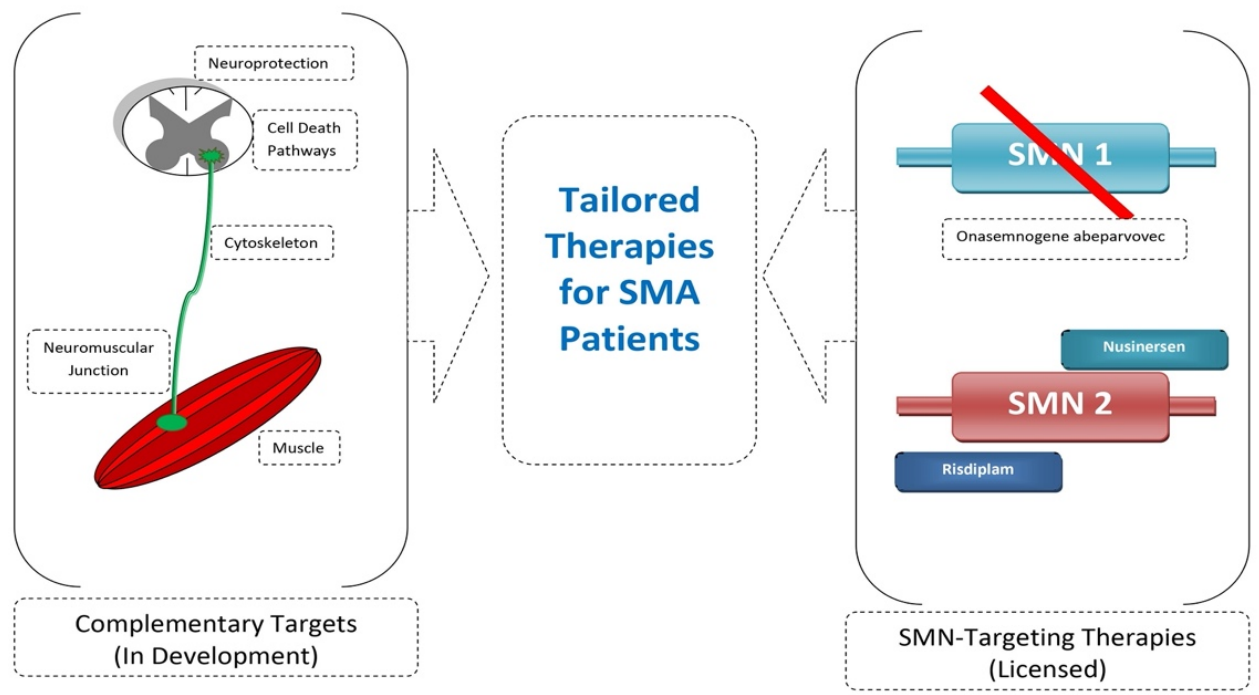
Figure 4. Combined SMN ‐ independent and SMN ‐ dependent therapy as future direction in SMA therapy.